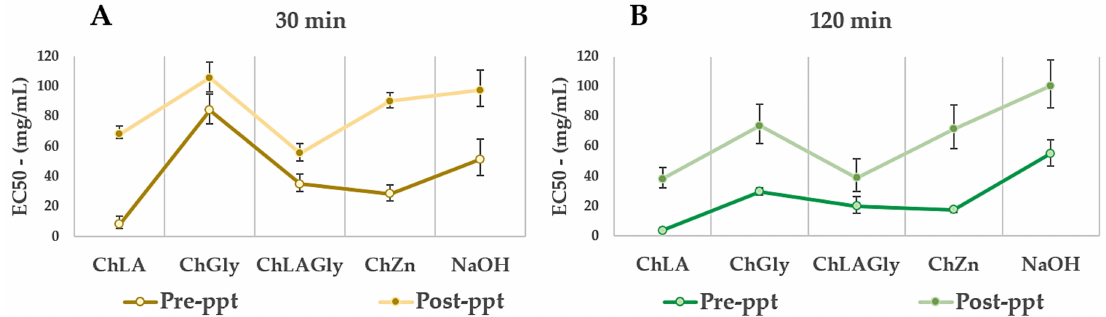
Figure 5. NaDES antioxidant power, expressed as EC50, pre- and post-lignin precipitation. ( A ): 30 min of treatment and ( B ): 120 min of